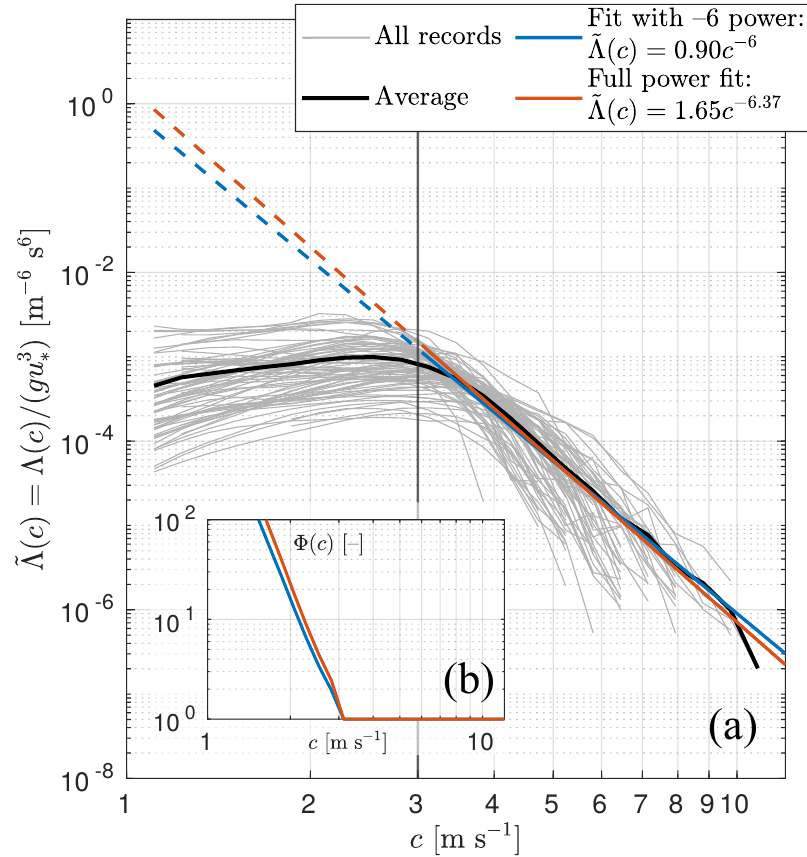
Figure A2. ( a ) Measured ˜ Λ ( c ) (gray lines) with their arithmetic average (black line). Vertical black line divides the range of phase speeds into the one used for the curve fitting (solid coloured lines) and for the extrapolation (dash coloured lines). ( b ) The correction function, Φ ( c ) , for both power